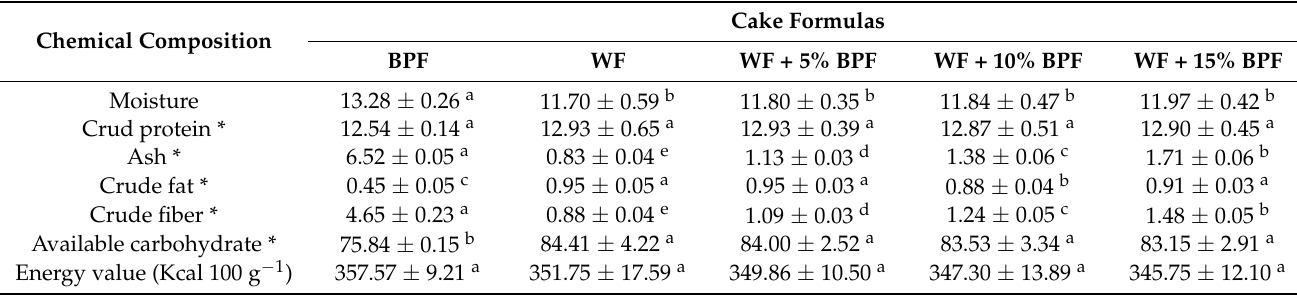
Table 2. The chemical composition of WF and various substituted WF with BPF ( A. digitate ).